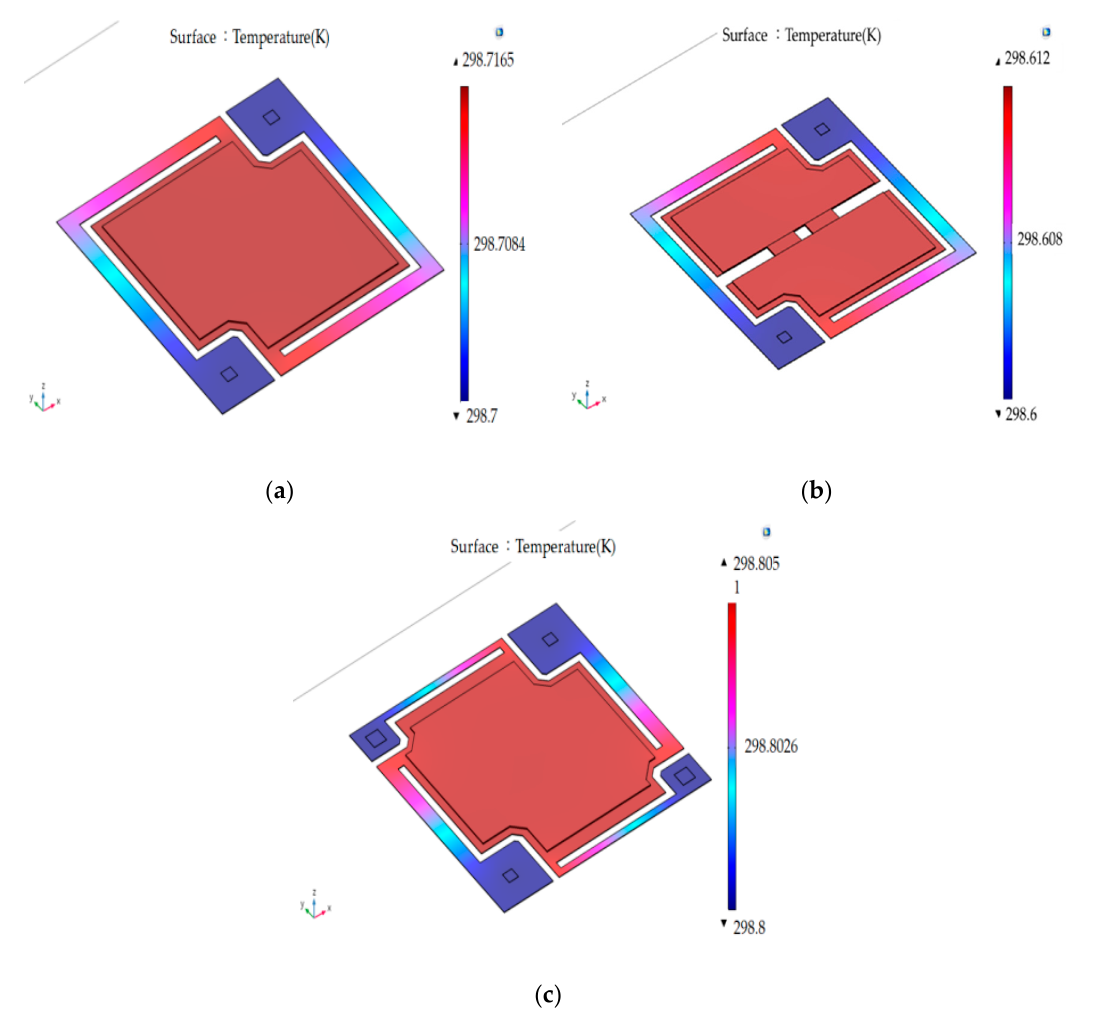
Figure 6. Thermal distribution of the surface of ( a ) Design 0 and Design 3; ( b ) Design 1 and ( c ) Design 2 under the same illuminated condition.